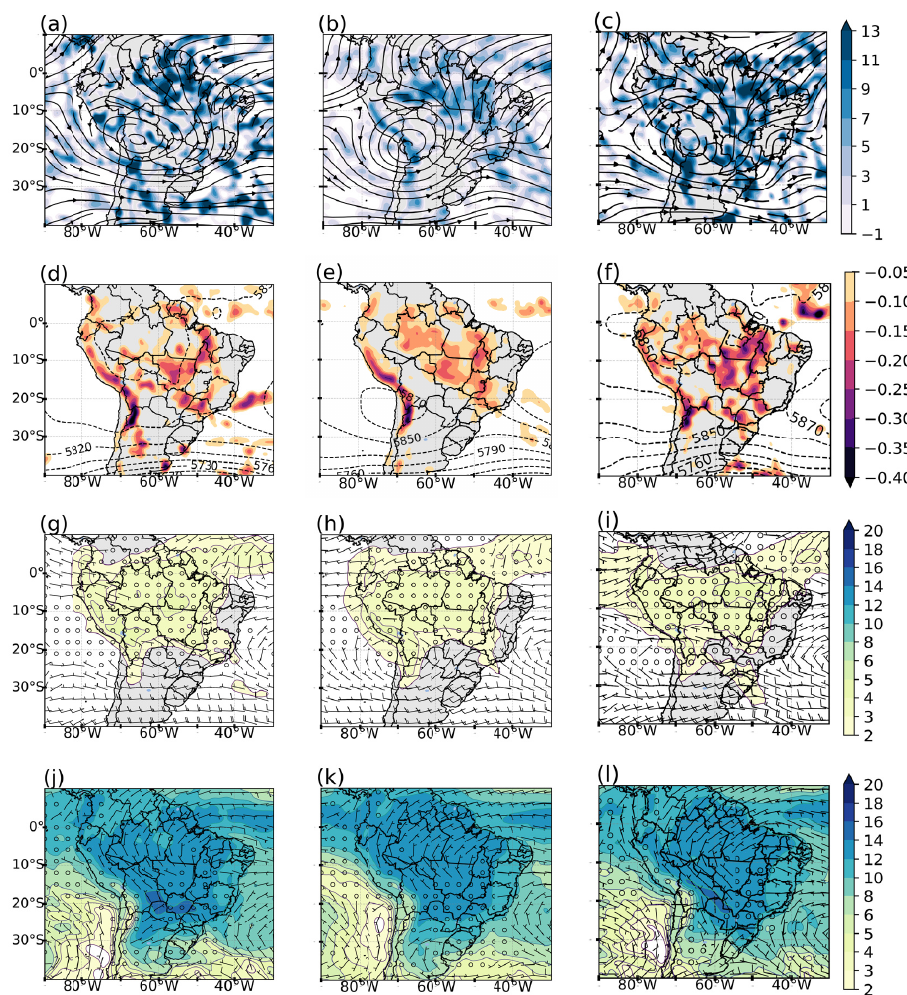
Figure 6. Composites of the streamlines and horizontal divergence of wind (1 × 10 − 5 · s − 1 ) at 250 hPa ( a – c ), geopotential height and omega (Pa · s − 1 ) at 500 hPa ( d – f ), specific humidity (g · kg − 1 ) and winds at 500 hPa ( g – i ) and at 850 hPa ( j – l ) for the − 3D (left), 0D (center), and +2D (right) panels of the SACZ events during the transition phase of the